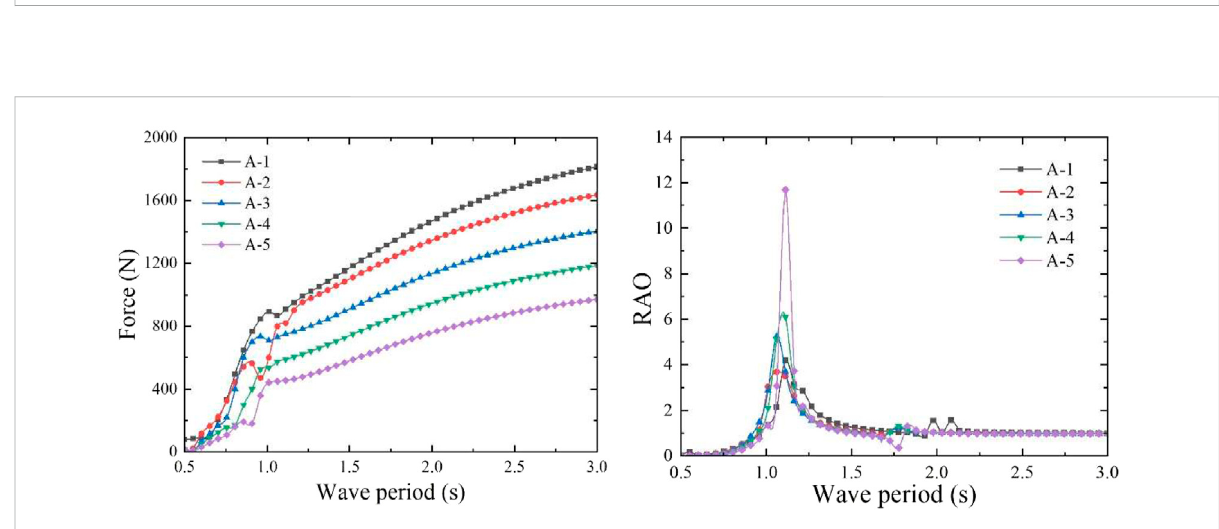
FIGURE 8 Wave force on the fi ve dual-chamber OWC models (left) and their heave RAO (right).